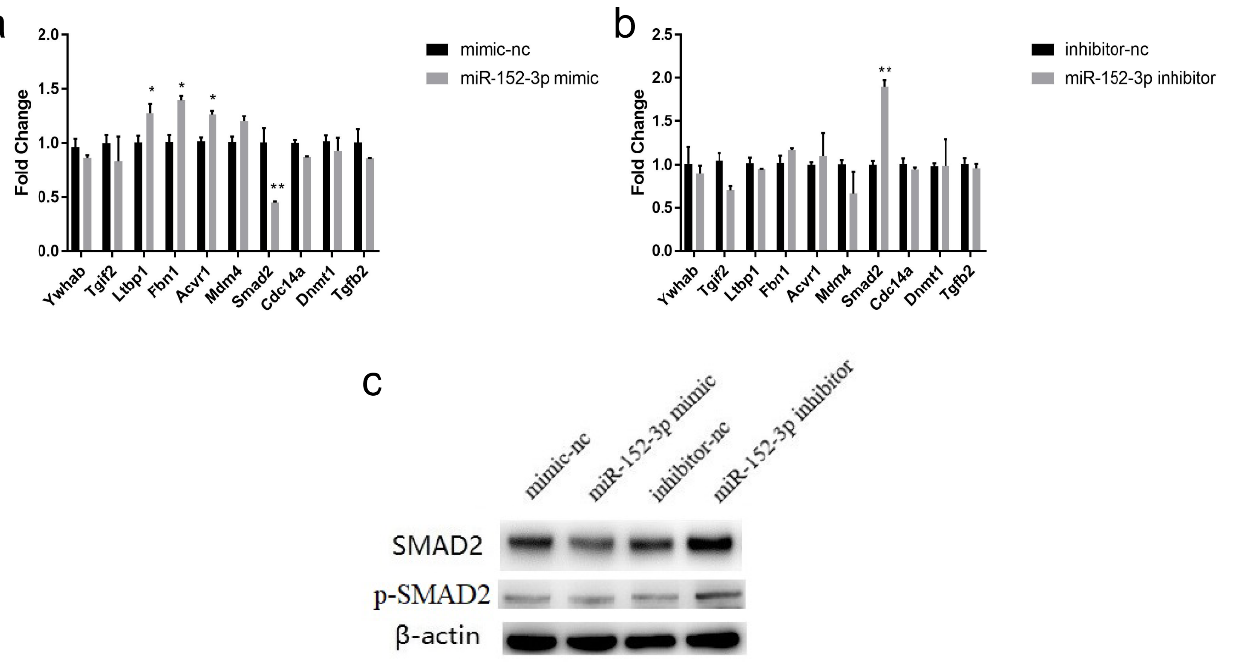
Figure 4. Screening of the miR-152-3p target genes. ( a , b ) The effect of miR-152-3p gain and silencing in the MTEC1 cells on the expression of 10 candidate target genes. ( c ) SMAD2 protein expression level in the MTEC1 cells. The RT-qPCR data were normalized to the level of β -actin for mRNA. Data were expressed as mean ± SD for three biological replicates (Student’s t -test: *, p < 0.05; **, p < 0.01).